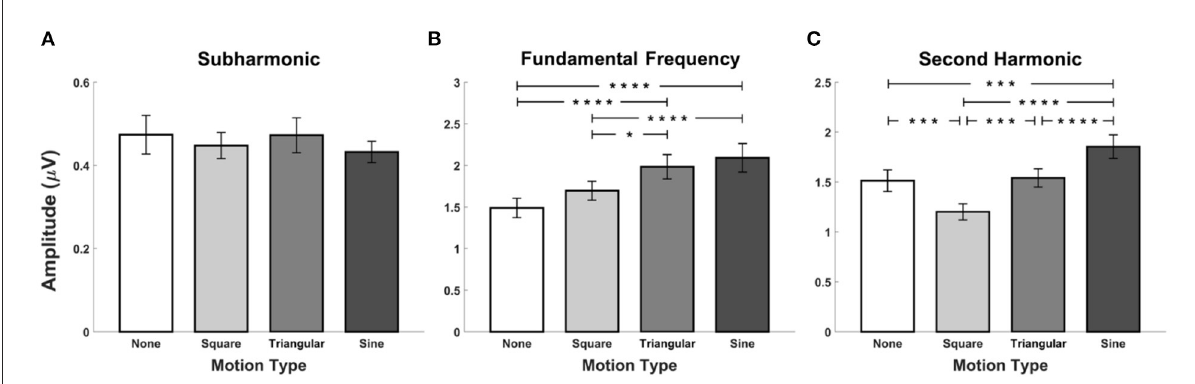
FIGURE4 Grand mean SSVEP amplitudes for FS-based hybrid visual stimuli averaged across all the participants at (A) the subharmonic frequency, (B) the fundamental frequency, and (C) the second harmonic frequency. Error bars represent the standard errors. Here, the asterisks of *, ***, and **** represent FDRs-corrected p < 0.05, p < 0.005, and p < 0.001, respectively (Wilcoxon signed-rank test).